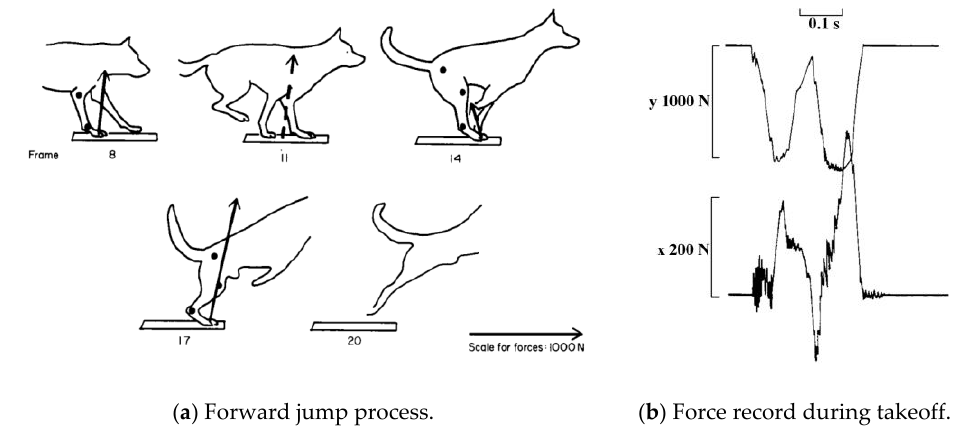
Figure 3. Research on the forward jump of an Alsatian dog; ( a ) tracings from the film of the long jump, ( b ) the force record during takeoff [14]. jump, ( b ) the force record during takeoff